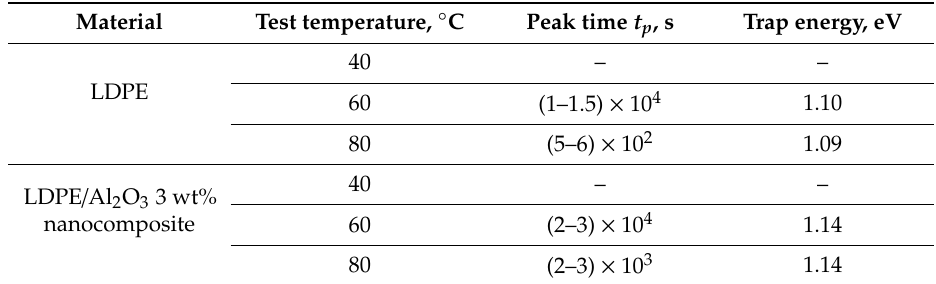
Table 1. Peak time t p of the plots of I × t vs. log( t ) for discharge currents and corresponding trap energy calculated by Equation (3).